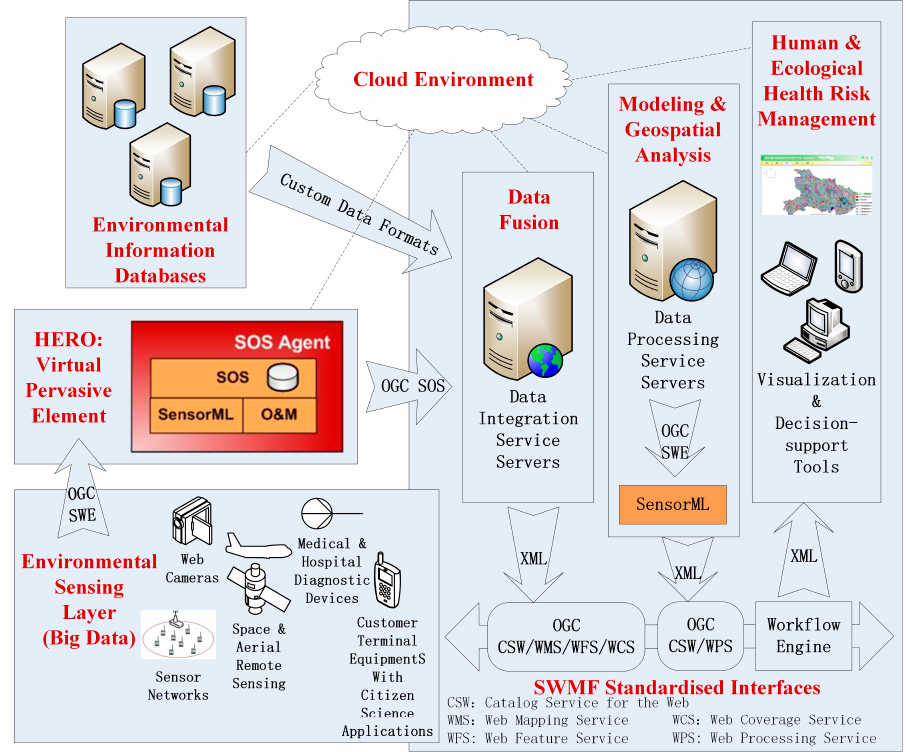
Figure 5. HaEHMS Technical Architecture.